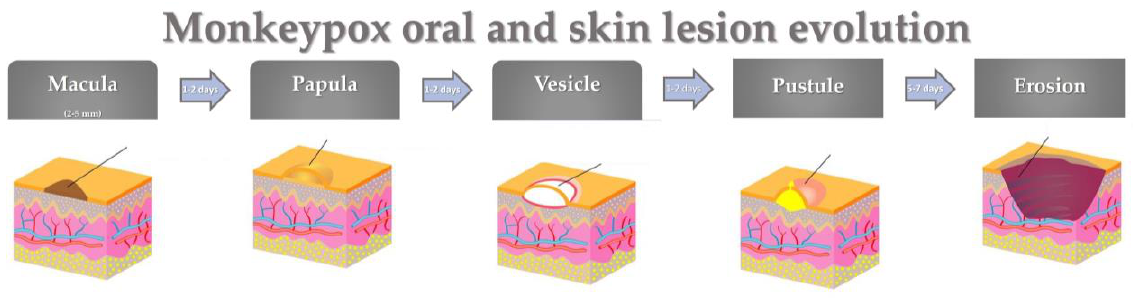
Figure 3. Monkeypox oral and skin lesion